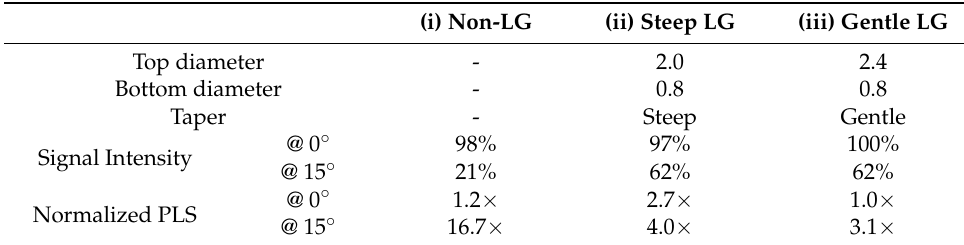
Figure 9. Simulated ( a ) sensitivity and ( b ) PLS results of incident light angle dependence. Table 1. Simulated optical performance summary.